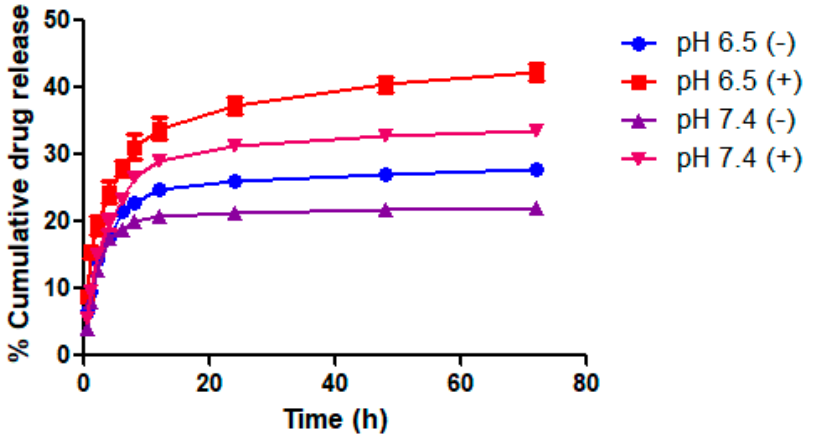
Figure 8. In vitro release behavior of DOX from T GNC-DOX at different pH conditions i.e., pH 6.5 and pH 7.4. The ( − ) indicates without NIR laser irradiation (+) indicates NIR laser treatment groups. Upon 808 nm NIR laser irradiation, the release rate of DOX was found to be further increased. The percentage of DOX released after 72 h was significantly higher at pH 6.5